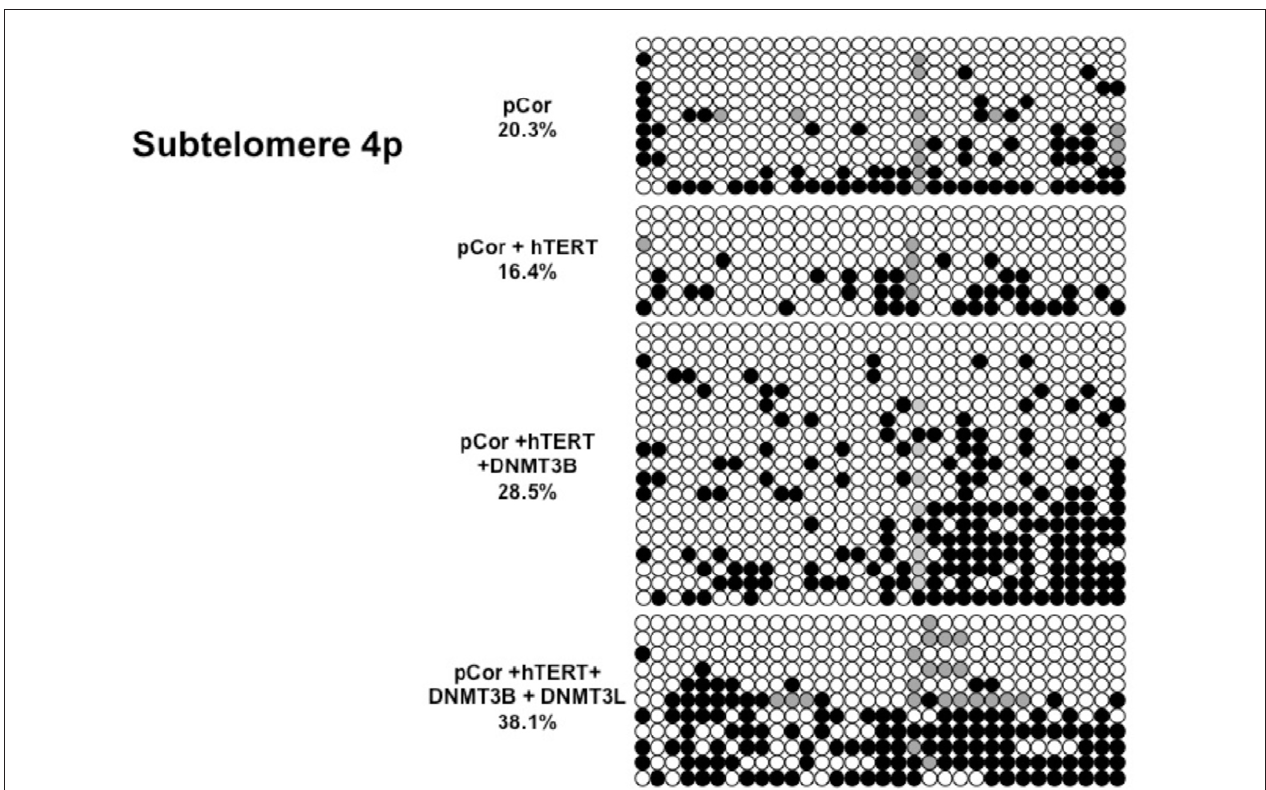
FIGURE A3 | Bisulfite analysis of subtelomeric region 4p. Bisulfite sequence analysis was carried out for a region in subtelomere 4p in pCor, pCor + hTERT, pCor + hTERT + DNMT3B1 and pCor + hTERT + DNMT3B1 + DNMT3L fibroblasts. The analyzed region contains 32 CpG sites. White circles represent unmethylated CpG